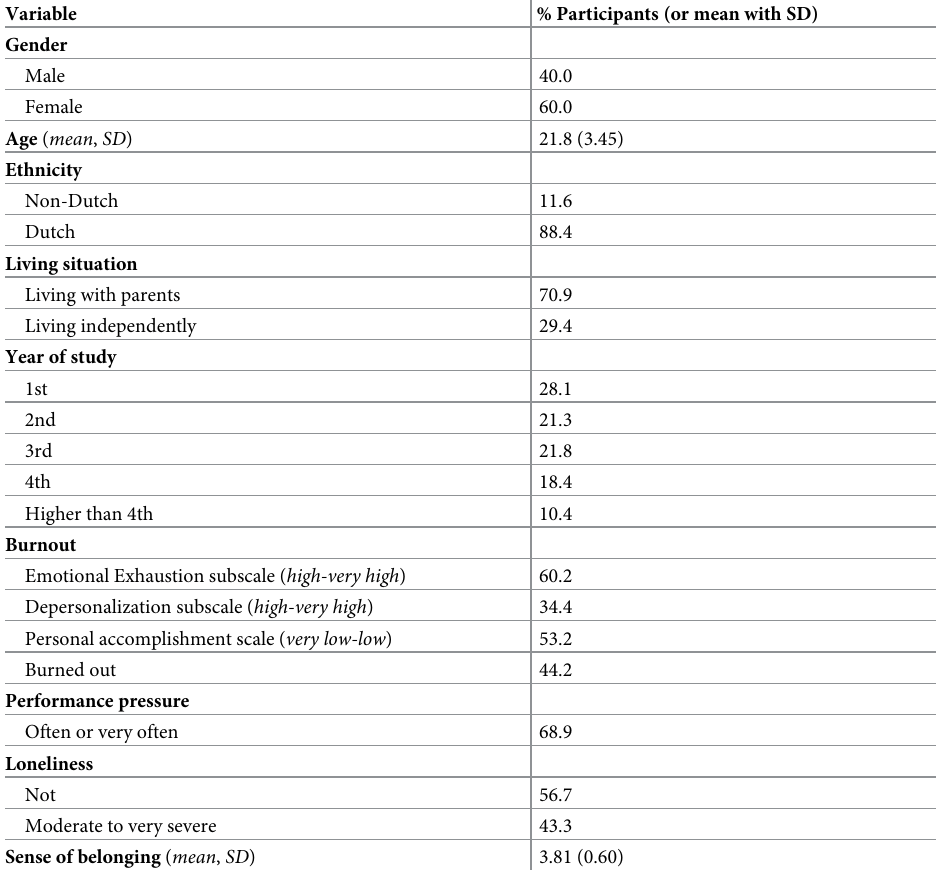
Table 1. Sample characteristics ( N =